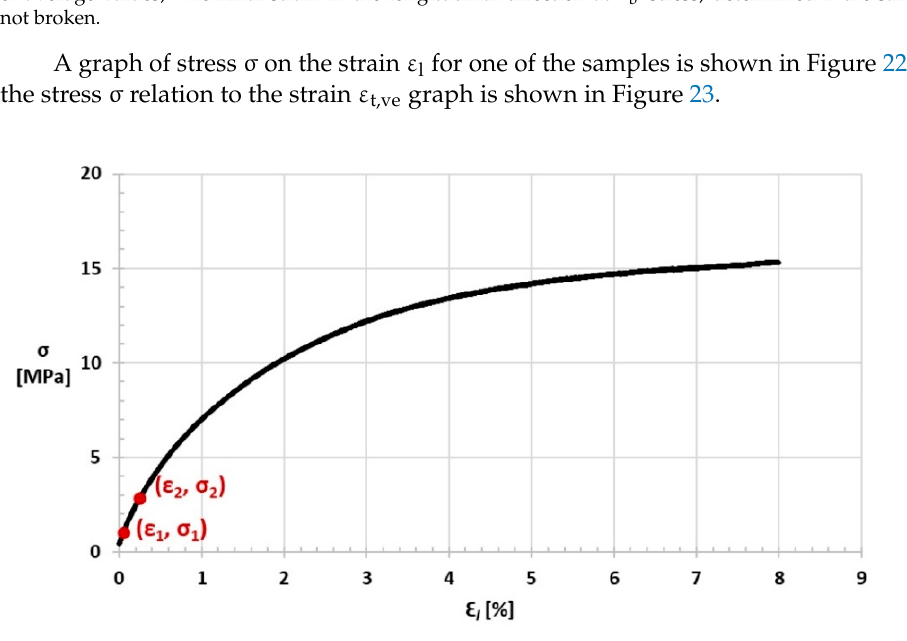
Figure 23. Stress σ relation to strain ε t,ve graph. The test samples were not broken, a sample rupture or elongation of the sample measured using an elongated extensometer equal to that of the 4 mm. 3.3. Compression Test of Airfield Geocell Made of Recycled Plastic Materials The results obtained for the test samples are presented in tables: Table 8—results of determination of compressive strength σ mr ; Table 9—compressive strain results ε mr determined from the displacement of the moving compressive plate relative to the base plate; and Table 10—compressive strain results ε mr,ve determined by video-extensometer. Table 8. Results of determination of compressive strength σ mr . Sample Number